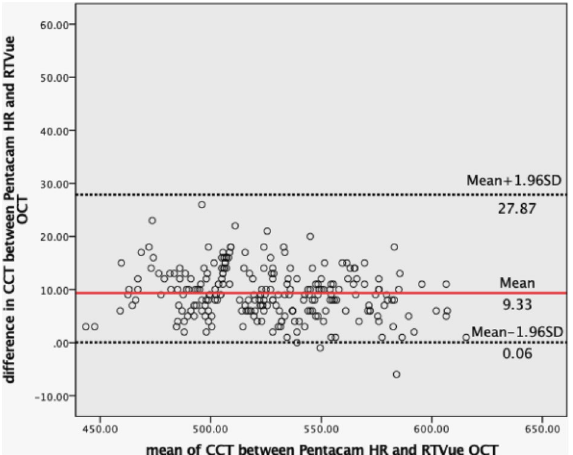
Figure 3. Bland–Altman plots show the agreement of CCT between the Pentacam HR and RTVue OCT. The solid red line represents the mean difference, and the black dotted lines represent the 95% limits of